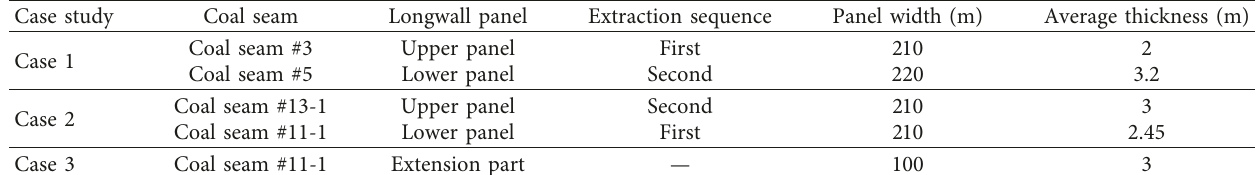
Table 2: Panel dimensions and extraction sequence of all the case